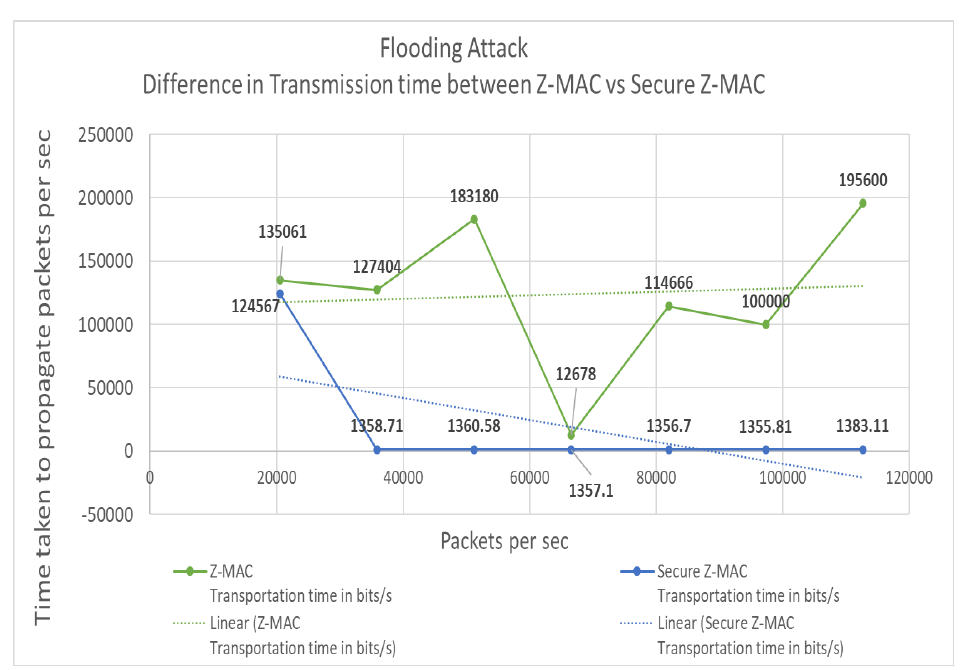
Figure 11. Graph simulating the transmission time during a flooding attack against the packets transmitted in byte format in the secure Z-MAC scheme compared to Z-MAC.